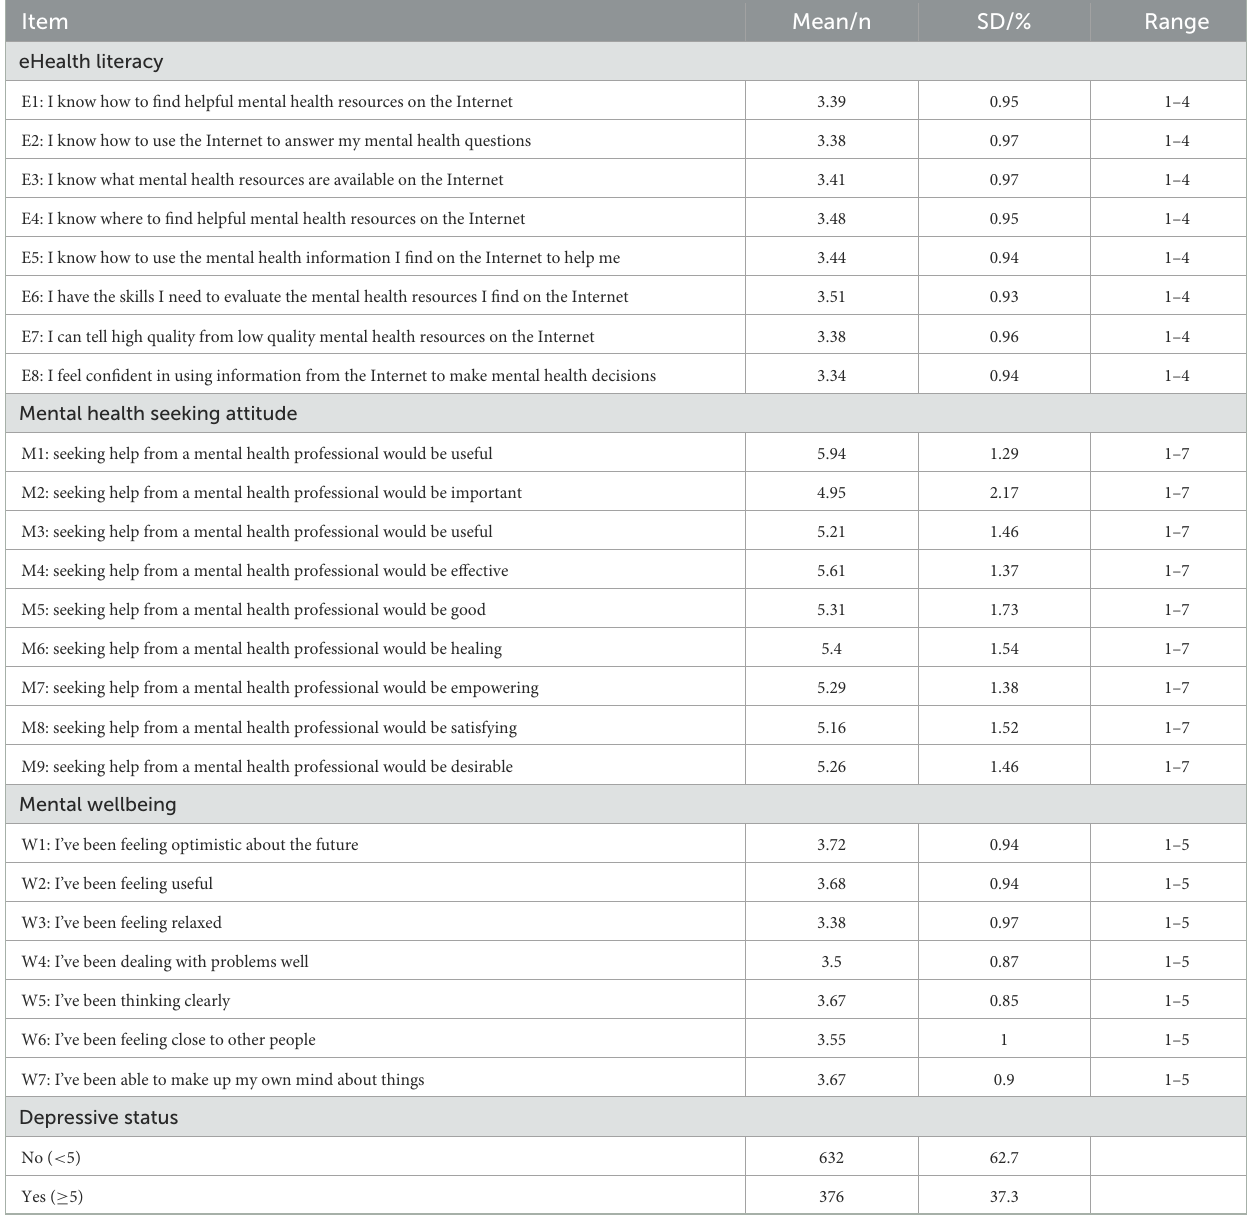
TABLE 2 Participants’ eHL, attitude for seeking mental health services, and mental wellbeing. Item Mean/n SD/% Range eHealth